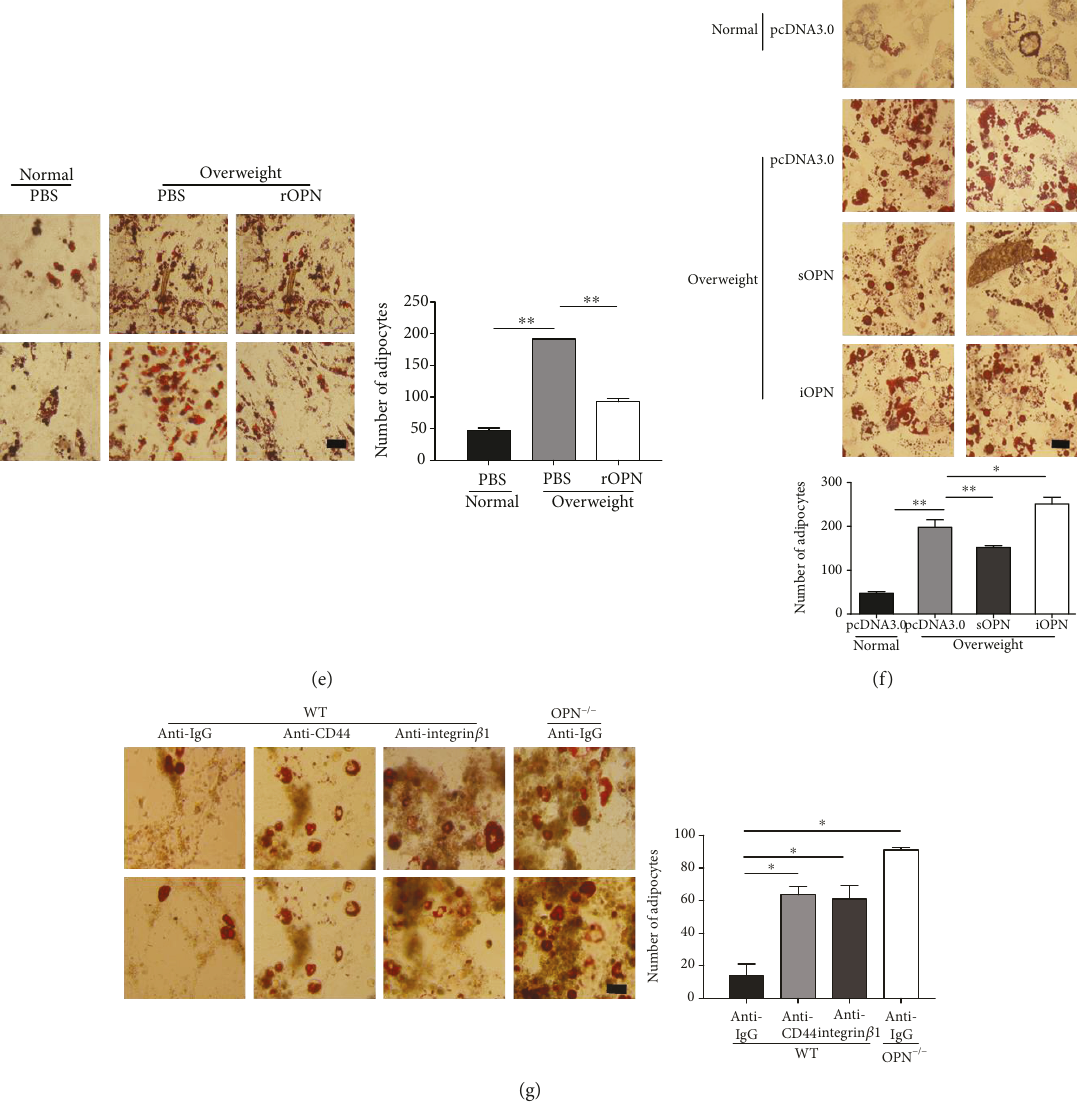
Figure 4: OPN retards the adipogenic di ff erentiation of ASCs mainly in an extracellular manner. (a) WT and OPN − / − ASCs were cultured in adipogenic di ff erentiation medium supplemented with OPN-speci fi c antibody (anti-OPN Ab) or isotype control (each 10 μ g/ml), then stained with Oil Red O after 4 days. (b) OPN − / − and WT ASCs, transfected with secreted OPN (sOPN), intracellular OPN (iOPN), or pcDNA3.0, were cultured in adipogenic di ff erentiation medium for 6 days, then stained with Oil Red O. (c) OPN − / − and WT ASCs were cultured in adipogenic di ff erentiation medium supplemented with recombinant OPN (rmOPN, 1 μ g/ml) or PBS [27] for 4 days and stained with Oil Red O. (d) hASCs, from overweight (25 ≤ BMI < 30) and normal (BMI < 25) human subjects, were cultured in adipogenic di ff erentiation medium supplemented with OPN-speci fi c antibody (anti-OPN Ab) or isotype control (each 10 μ g/ml) for 6 days, then stained with Oil Red O. (e) Overweight and normal ASCs were cultured in adipogenic di ff erentiation medium exposed to PBS and recombinant OPN protein (each 1 μ g/ml) (rOPN) for 4 days, and then stained with Oil Red O. (f) Overweight and normal ASCs, transfected with secreted OPN (sOPN), intracellular OPN (iOPN), or pcDNA3.0, were subjected to adipogenic di ff erentiation medium for 6 days, then stained with Oil Red O. (g) WT and OPN − / − ASCs supplemented with blocking antibodies against integrin αν / β 1 or CD44 or an isotype control (lgG; each 5 μ g/ml) was cultured in adipogenic di ff erentiation medium for 4 days and stained with Oil Red O. Adipocyte size was quanti fi cation analyzed by an imaging system (ImageJ, National Institutes of Health). (Bar =50 μ m; adipocytes counted in four random fi elds from two wells per group.) Values are means ± SEM. ∗ P < 0 05 ; ∗∗ P < 0 01 ; ∗∗∗ P < 0 001 . All experiments were repeated at least